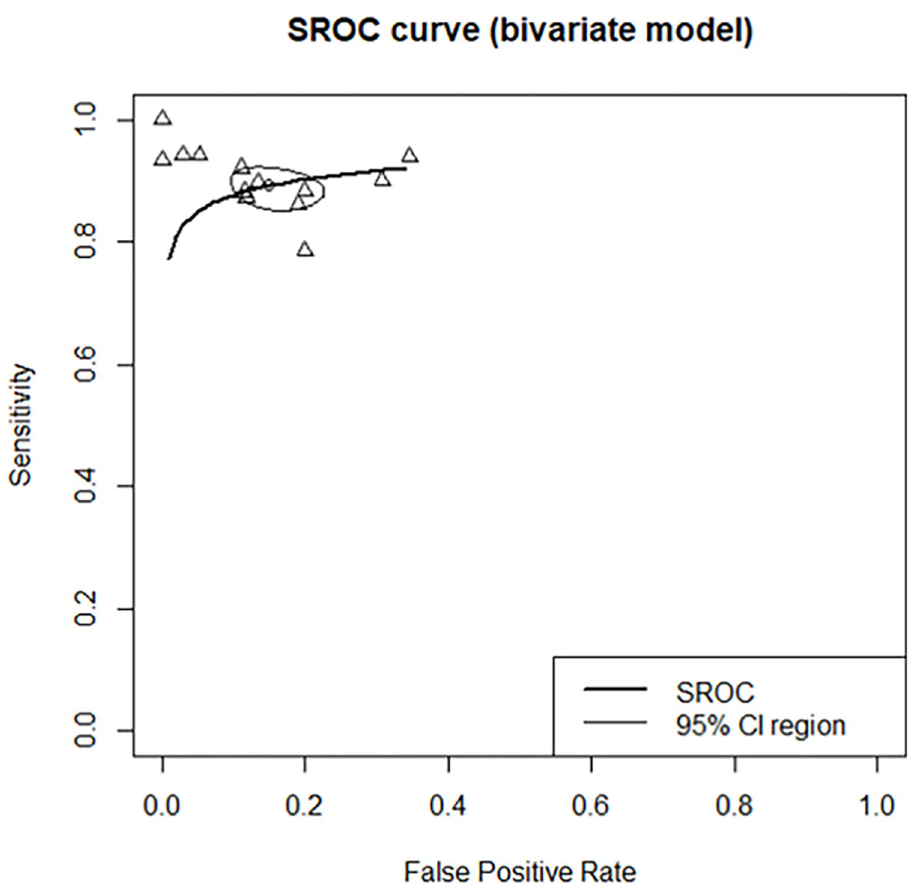
Fig 3. Area under the summary receiver operating characteristic curves of included